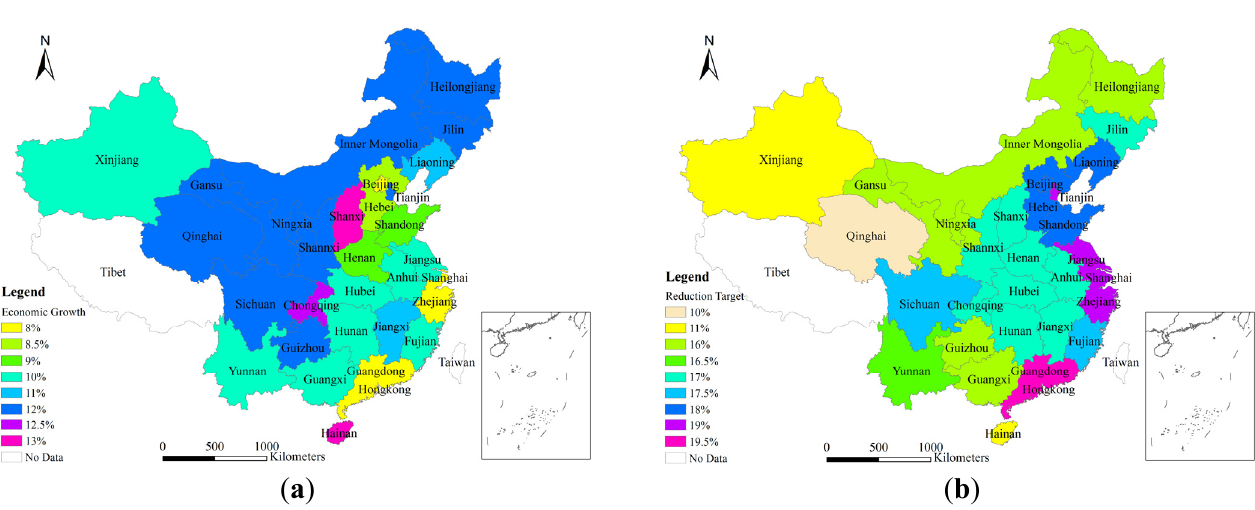
Figure 3. Target setting in 30 provinces ( a ) China’s economic growth target in 12th FYP. ( b ) China’s CO 2 emission reduction target in 12th